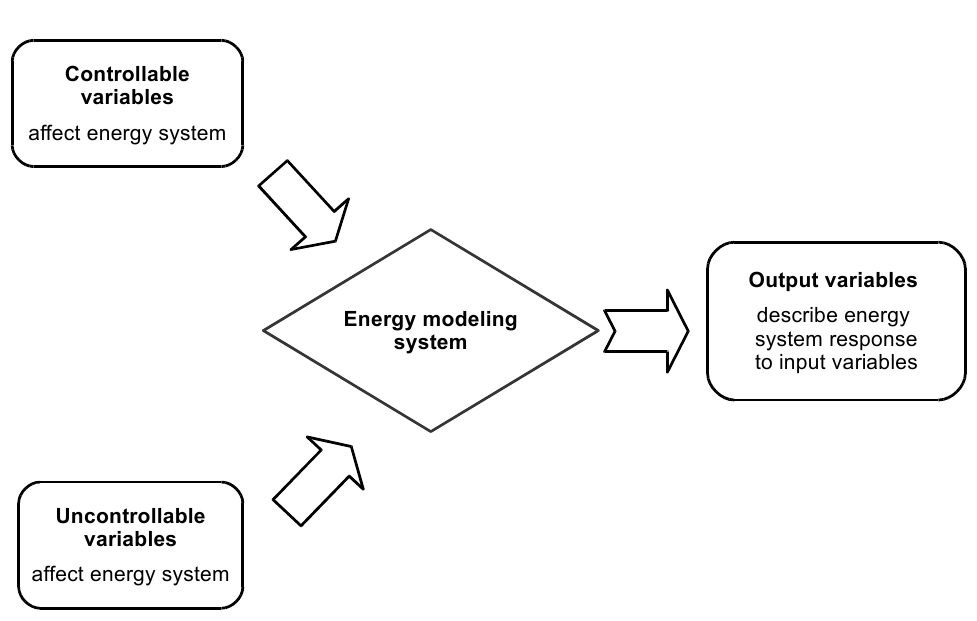
Figure 3. Structure of a building energy system [115].